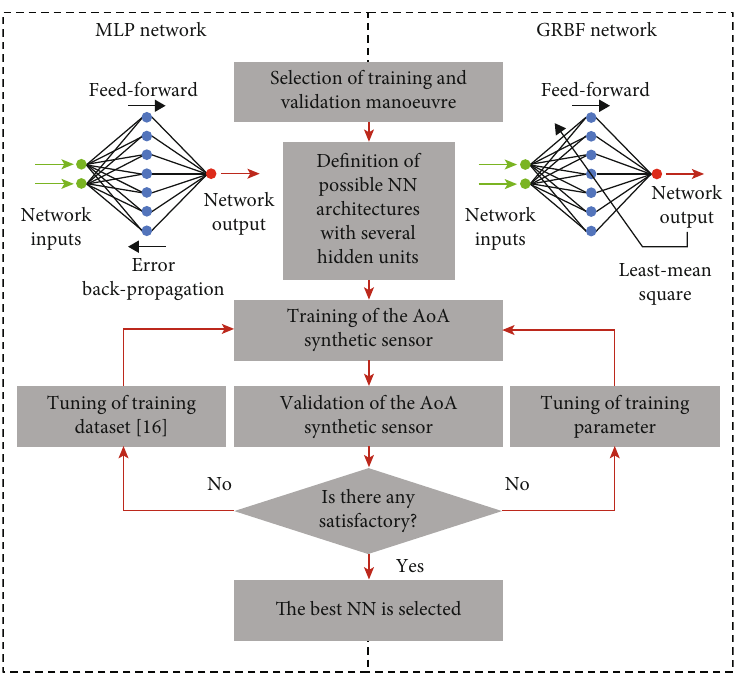
Figure 1: AoA synthetic sensor trade-o ff : fl ow charts for MLP and GRBF